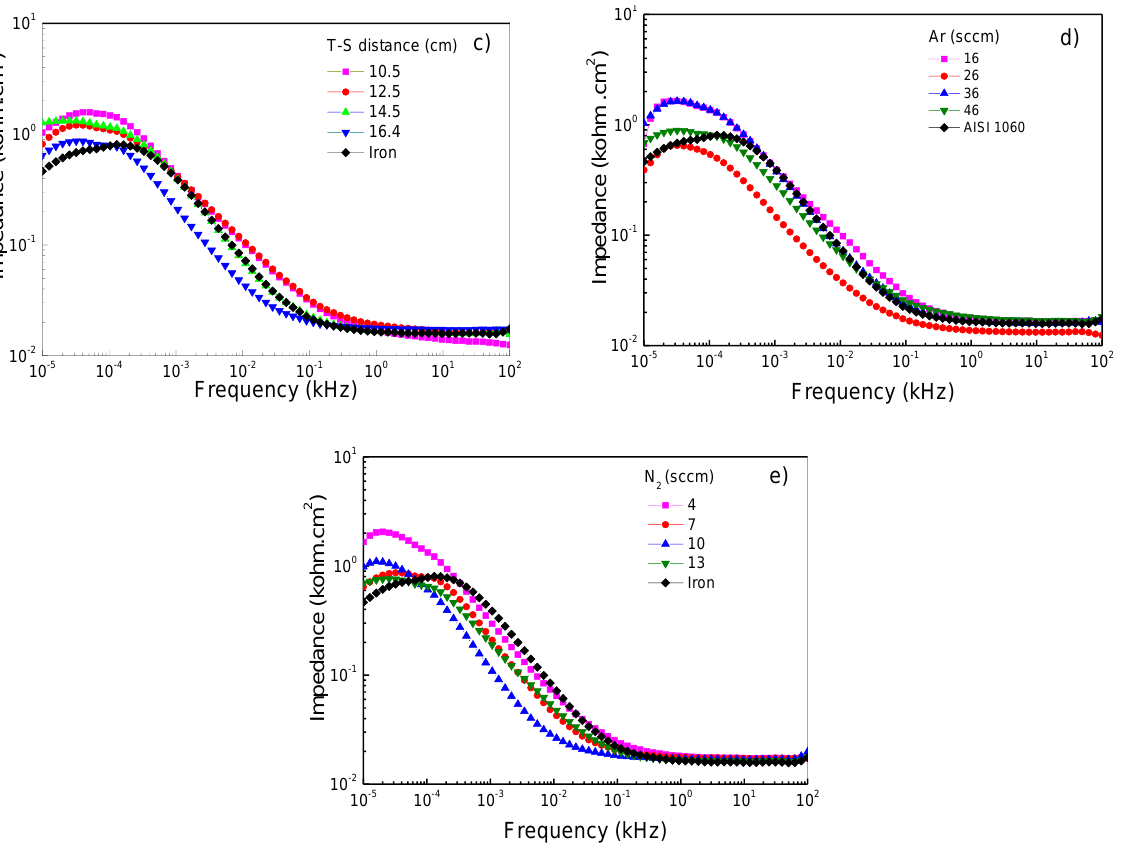
Figure 5. Bode plots of Ti/Ti 2 N of coated and uncoated AISI 1060 samples in 3.5 wt% NaCl solution at room conditions varying the following sputtering parameters: ( a ) RF-power, ( b ) temperature on substrate, ( c ) target–substrate distance, ( d ) argon flow mass, and ( e ) nitrogen flow mass. Table 4. Fitting results of EIS curves with the best behavior immersed in 3.5% NaCl solution. Parameter